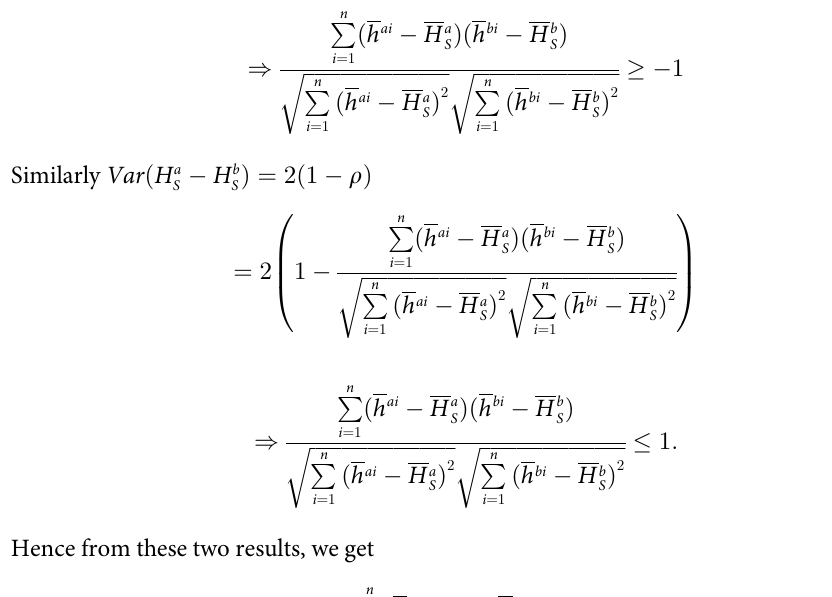
ffiffiffiffiffiffiffiffiffiffiffiffiffiffiffiffiffiffiffiffiffiffiffiffiffiffiffiffi P n